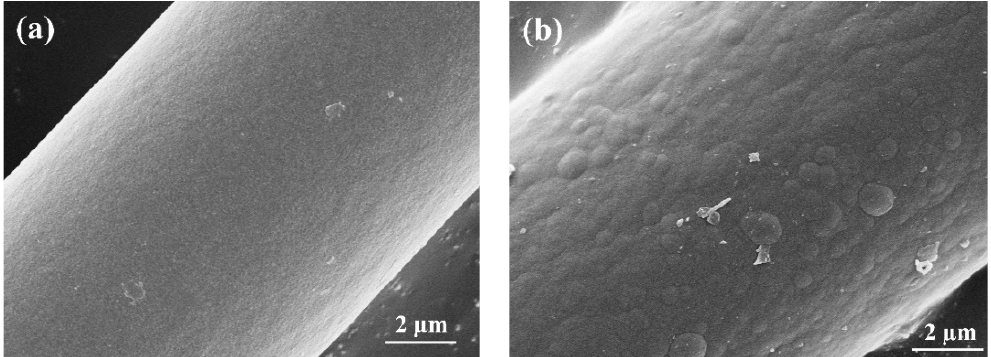
Figure 2. Surface morphology of the fibers without ( a ) and with ( b ) coatings.